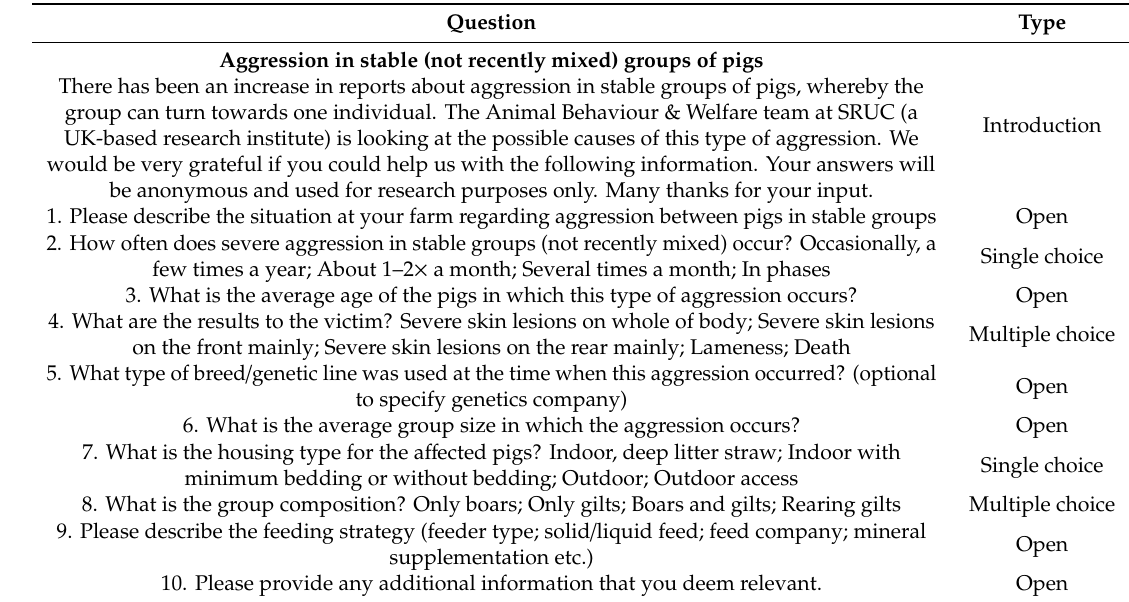
Table A1. Questions asked in the